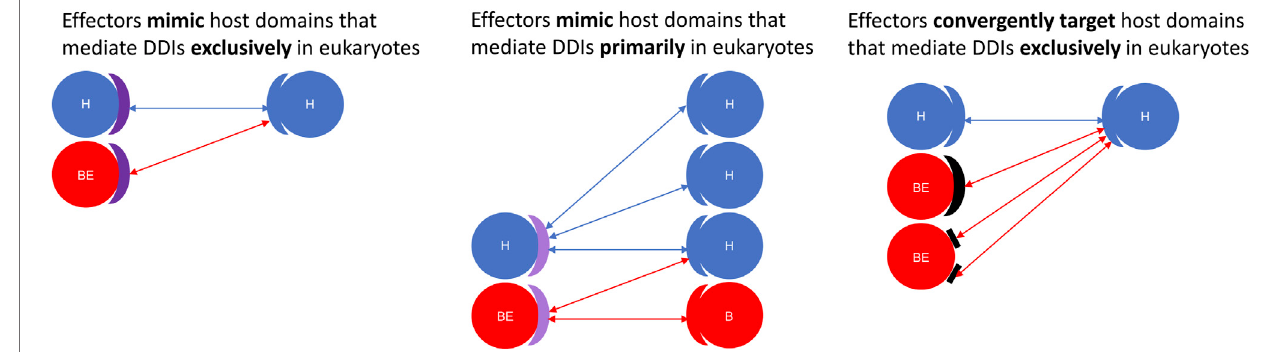
FIGURE7| Effectorsareenrichedforstructuralmodulesthateithermimicortargethostdomainsmediatingeukaryote-speci fi cdomain-domaininteractions.Using a domain-resolved eukaryote-bacteria protein-protein interaction network, we identi fi ed domains that mediate PPIs exclusively in eukaryotes (Left: deep purple arc), as well as domains that are more likely to co-occur with domain-domain interaction partners in eukaryotes rather than in bacteria (Middle: light purple arc). We found that compared to generic proteins encoded by pathogenic bacteria, effector proteins are signi fi cantly enriched for domains and short linear motifs that either mimic or targethostdomainsmediatingDDIseitherexclusivelyorprimarilyineukaryotes. Left: EffectorsmimichostdomainsthatmediateDDIsexclusivelyineukaryotes; Middle: EffectorsmimichostdomainsthatmediateDDIsprimarilyineukaryotes; Right: Effectorsconvergentlyevolvedomainsandshortlinearmotifstotargethostdomainsthat mediateDDIs exclusivelyineukaryotes. H (cid:2) host protein; B (cid:2) generic bacterial protein; BE (cid:2) bacterial effector protein. Domains are represented asblue (eukaryotic),red (bacterial), purple (eukaryotic-like and host-targeting), and black (convergently evolved and host-targeting) arcs. Short linear motifs are represented as